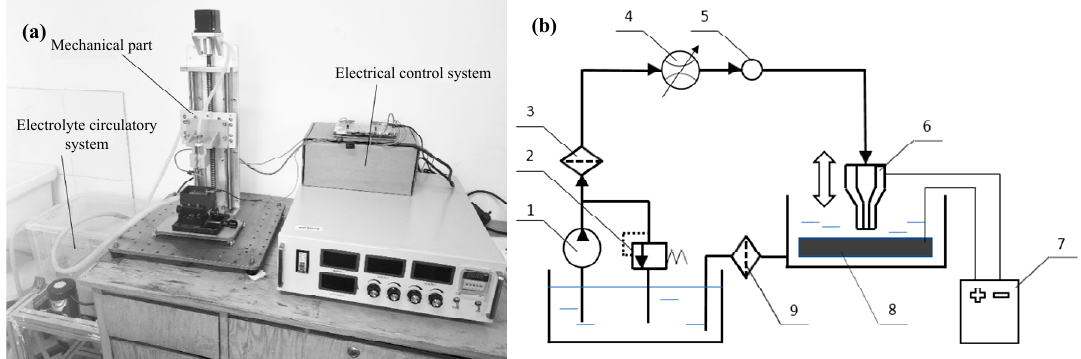
Figure 1. ( a ) Experimental system of electrochemical machining. ( b ) Design of experimental setup system: (1) flow pump with high pressure; (2) relief valve; (3) filter; (4) pressure regulating valve; (5) pressure gauge; (6) tool cathode; (7) power supply; (8) tool anode; (9) filter.